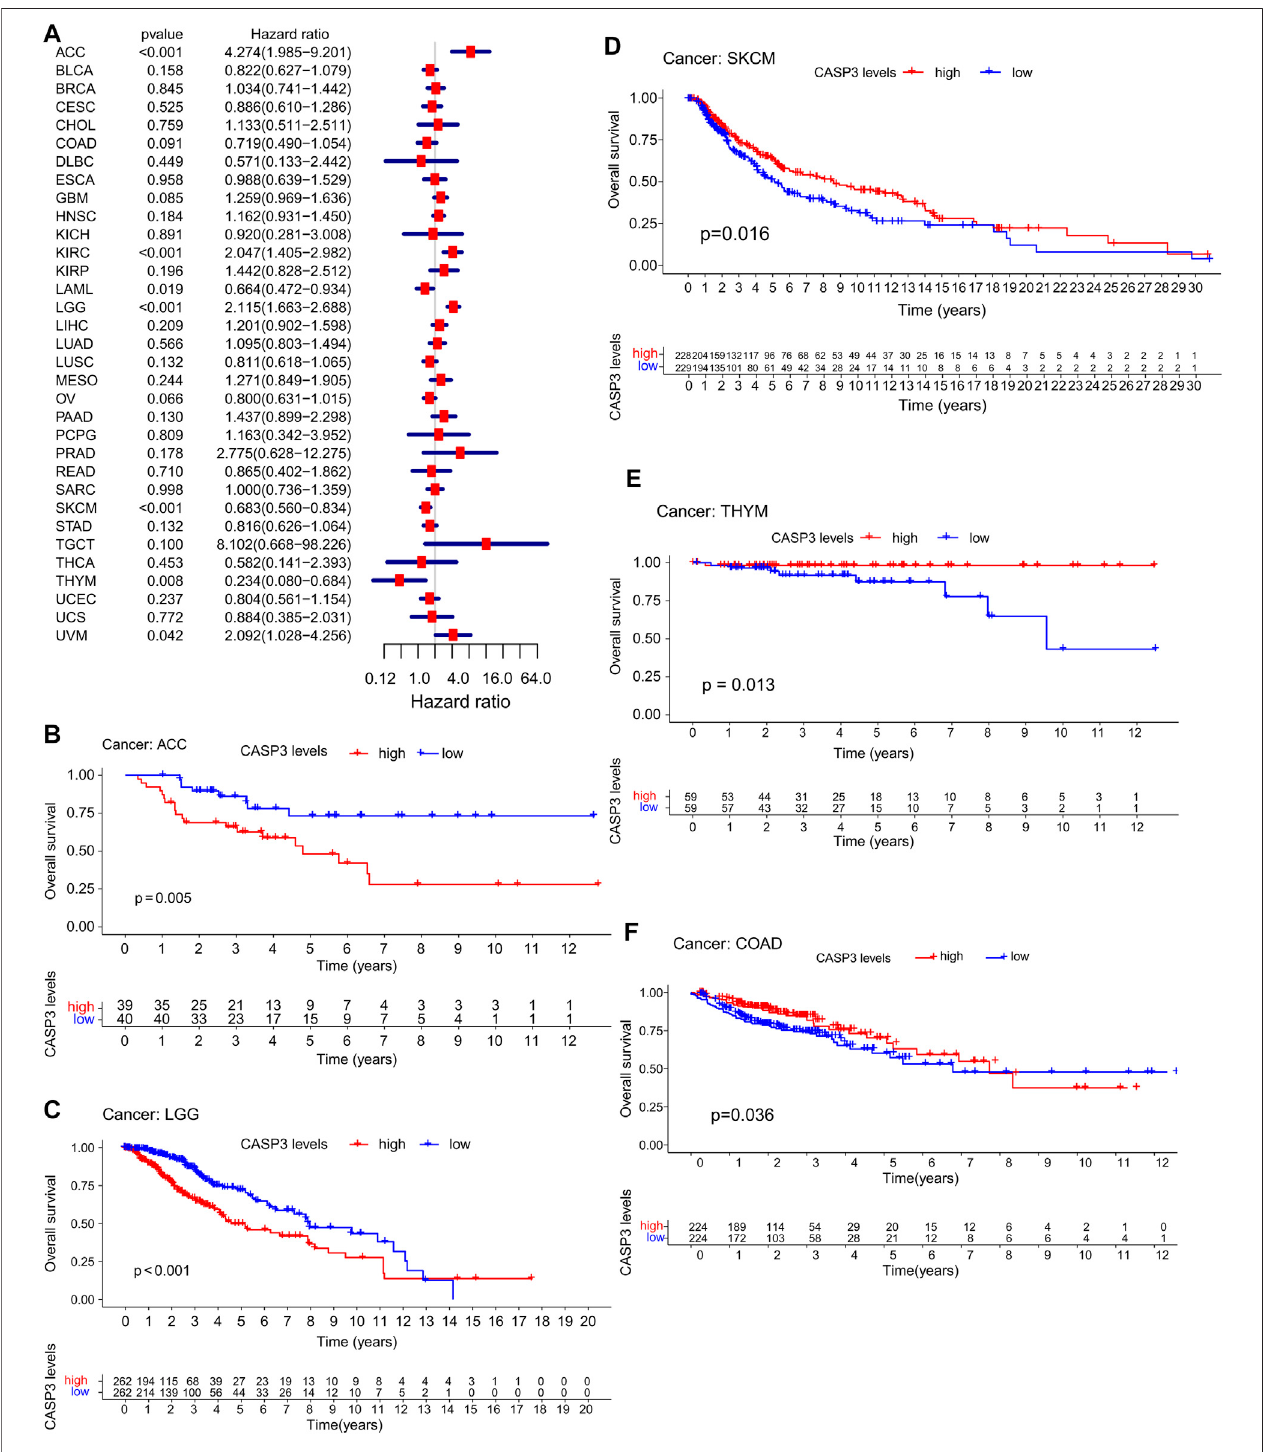
FIGURE 3 | Relationship between CASP3 expression and OS and DSS. (A) Expression of CASP3 is associated with OS in 33 tumour types. (B – F) Kaplan-Meier survivalanalysisof CASP3 expression andspeci fi ctumours ’ OS. (G) Expressionof CASP3 and DSSrelated forest mapof33tumourtypes. (H – O) Kaplan-Meier survival analysisoftherelationship between CASP3 expression andspeci fi ctumourDSS. Relationship between CASP3 expression and OSand DSS(continuation of Figure3 ).